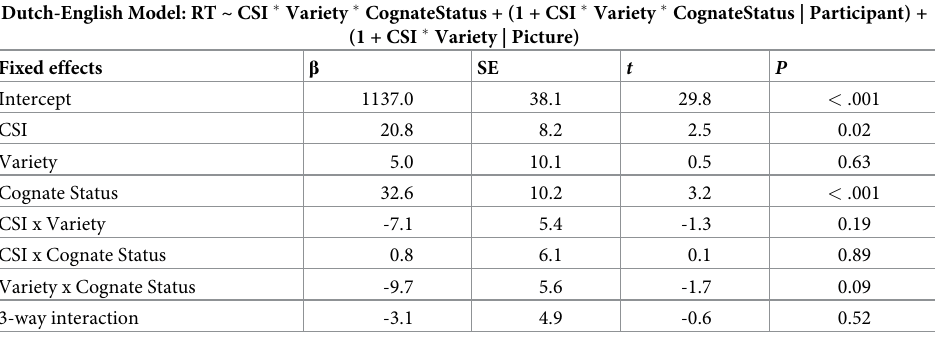
Table 2. Parameter estimates and results of significance tests in mixed-effects models for Experiment